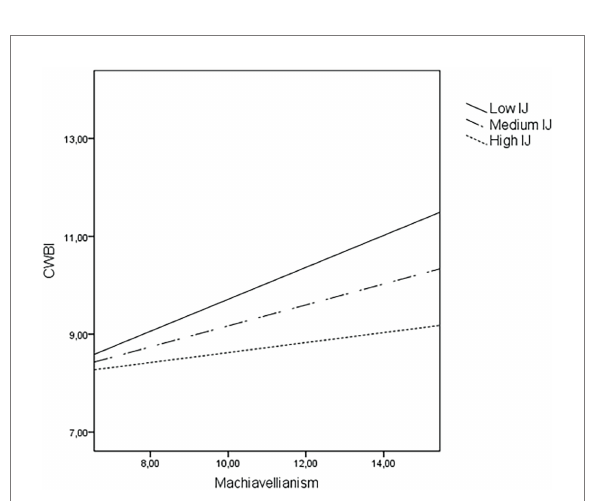
FIGURE 3 Moderating effects of perceived interactional justice (IJ) on the relationship between Machiavellianism and counterproductive work behavious targeting indiviauals